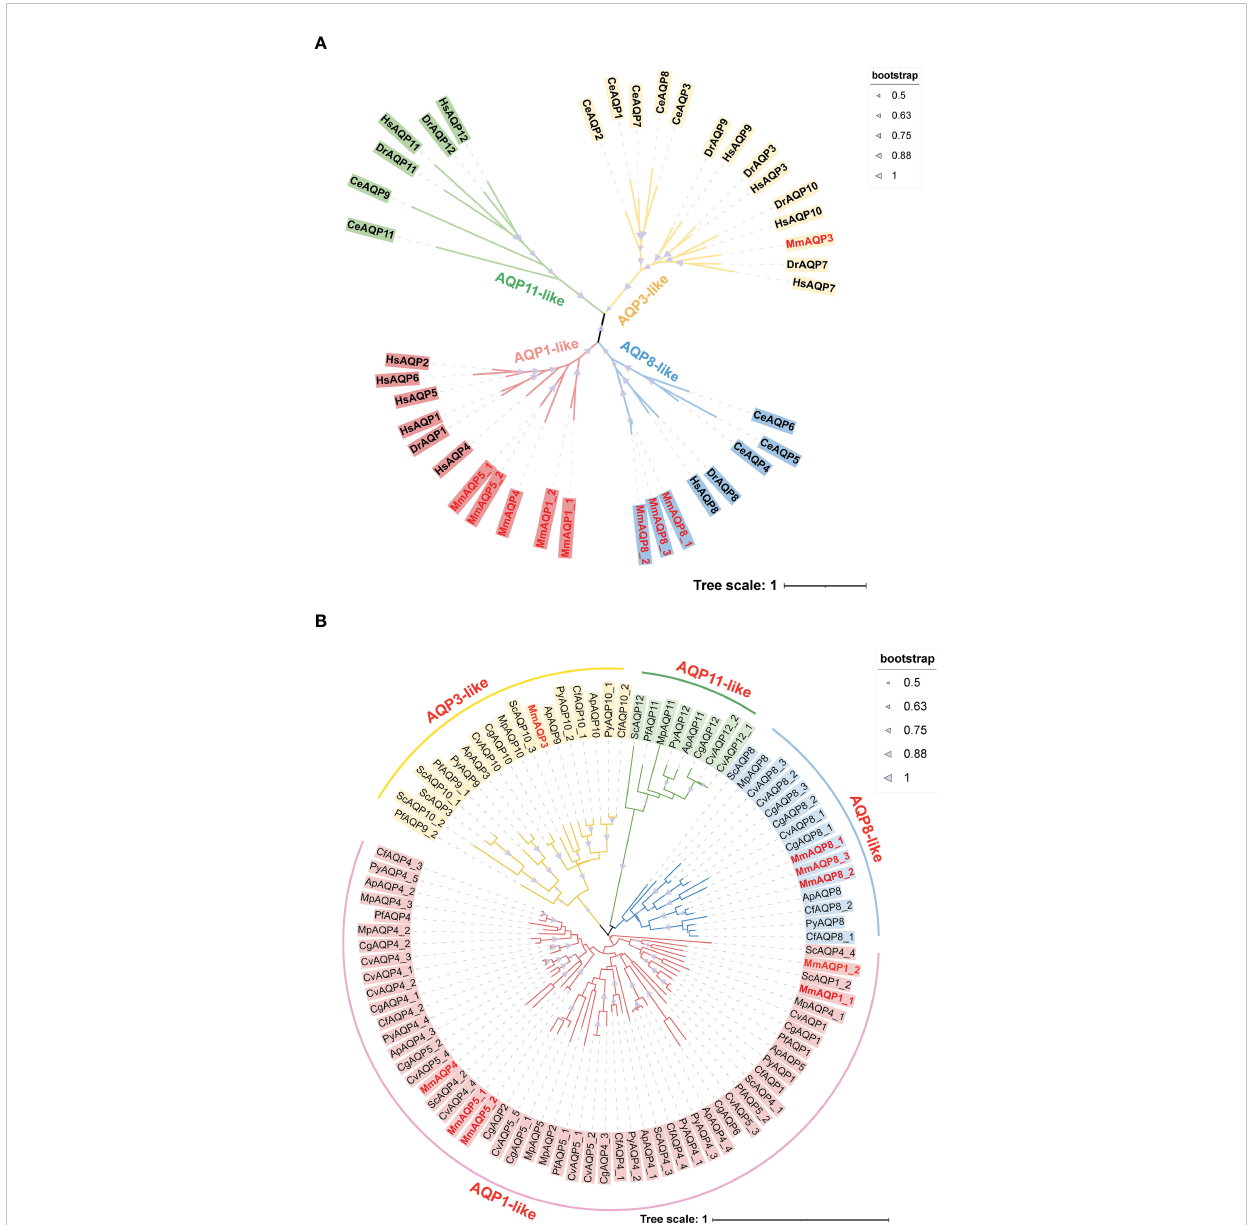
FIGURE 1 Phylogenetic analysis of MmAQPs and other known AQPs in three model organisms (A) , and the AQPs identi fi ed in nine bivalves (B) . The species names are abbreviated as follows, H. sapiens , Hs; D. rerio , Dr; C. elegans , Ce; C. gigas , Cg; C. virginica , Cv; P. fucata , Pf; A. purpuratus , Ap; C. farreri , Cf;